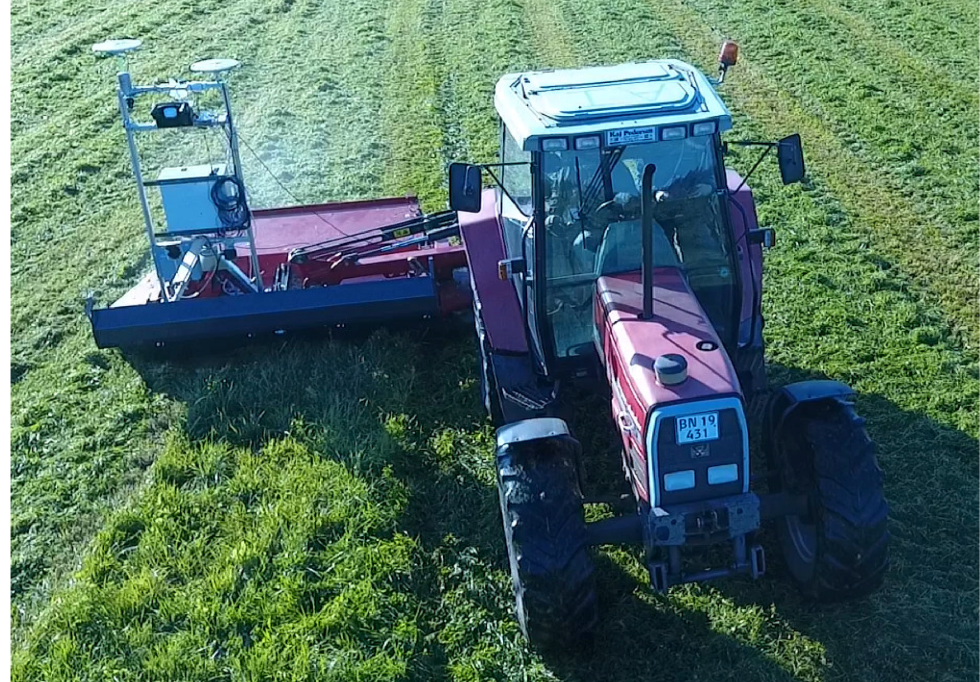
Figure 1. An example of a dual-antenna GNSS setup (see top left corner) mounted on a vehicle with the baseline lying sideways from one antenna to another. Image courtesy of Kragh et al.